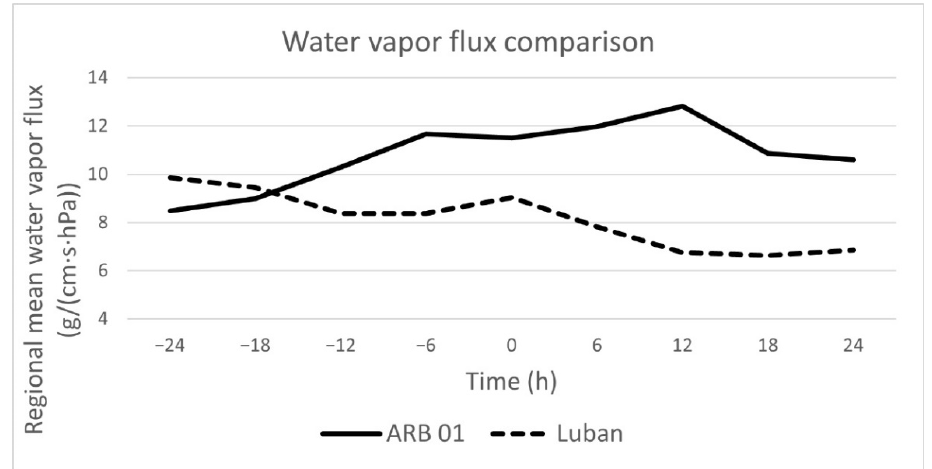
Figure 6. Regional (an area in a radius range of 1000 km centered on the landing site) average water vapor flux changes with time